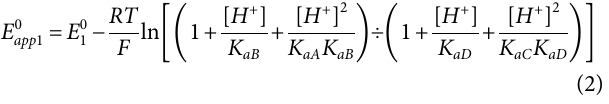
Frontiers in Chemistry |